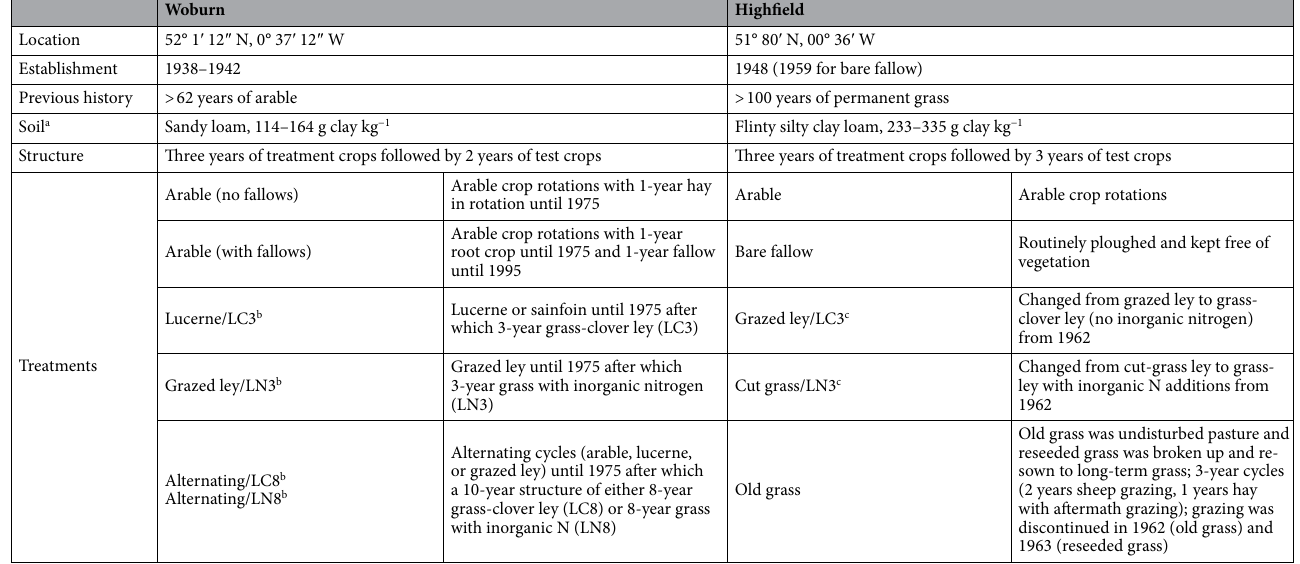
Table 1. Summary of treatments in the long-term experiments. a Clay concentrations for Woburn from Catt et al . 27 , and for Highfield from Jensen et al . 28 . b,c Change in treatment occurred at approximately the same time between samplings in all treatments of each experiment